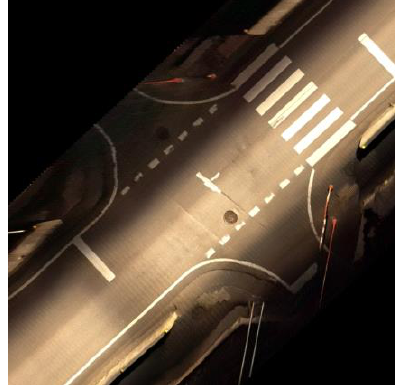
Figure 12 . Road ortho image at night.